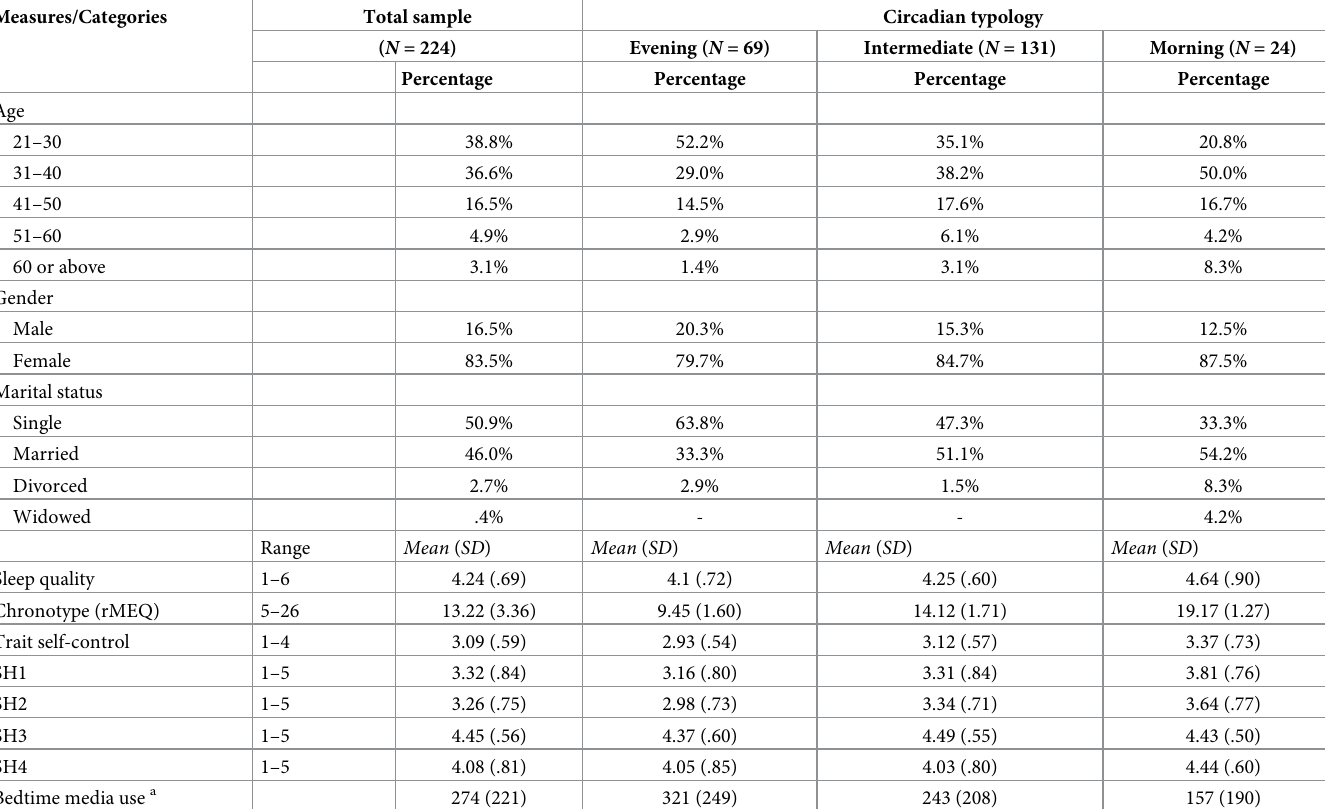
Table 2. Descriptive statistics of the total sample and by circadian